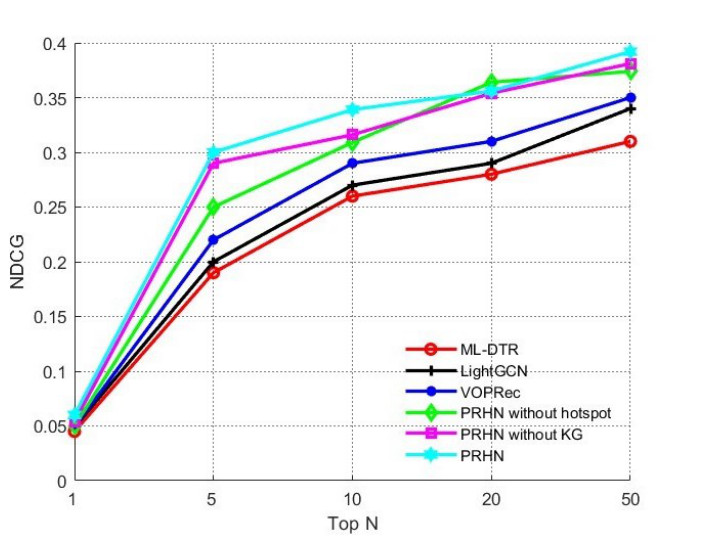
Figure 7. Performance metrics of NDCG for the three baseline models and our proposed model in metallurgical